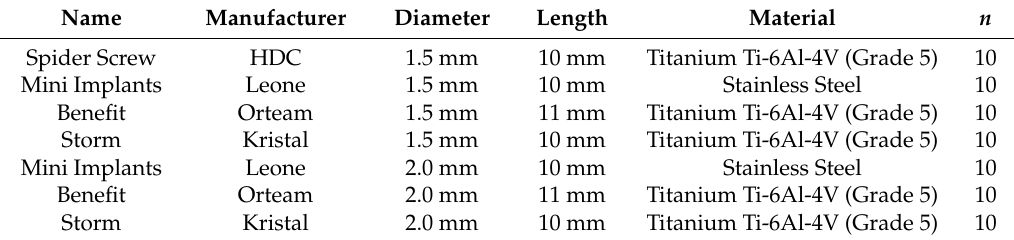
Table 1. Materials tested.